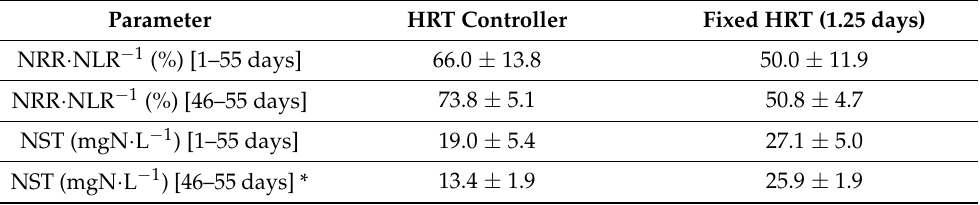
Table 5. Average results for the HRT controller and the fixed